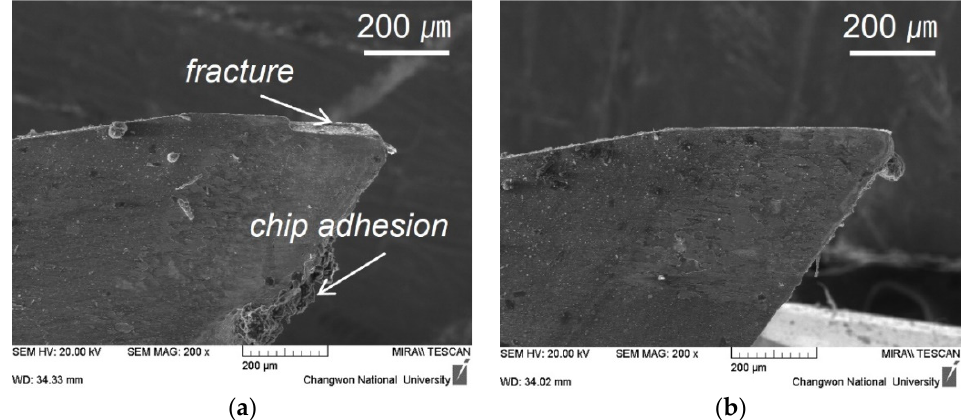
Figure 10. Microphotographs of the used cutting tool in experiment: ( a ) conventional end milling; ( b ) laser-assisted end milling (spindle speed: 5000 RPM, feed rate: 200 mm/min, depth of cut: 0.7 mm).